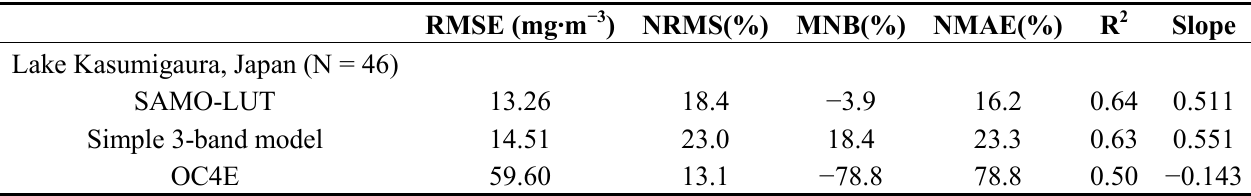
Table 3. Performance of the SAMO-LUT, Simple 3-band Model and OC4E for the estimation of Chl- a in Lake Kasumigaura, Japan.